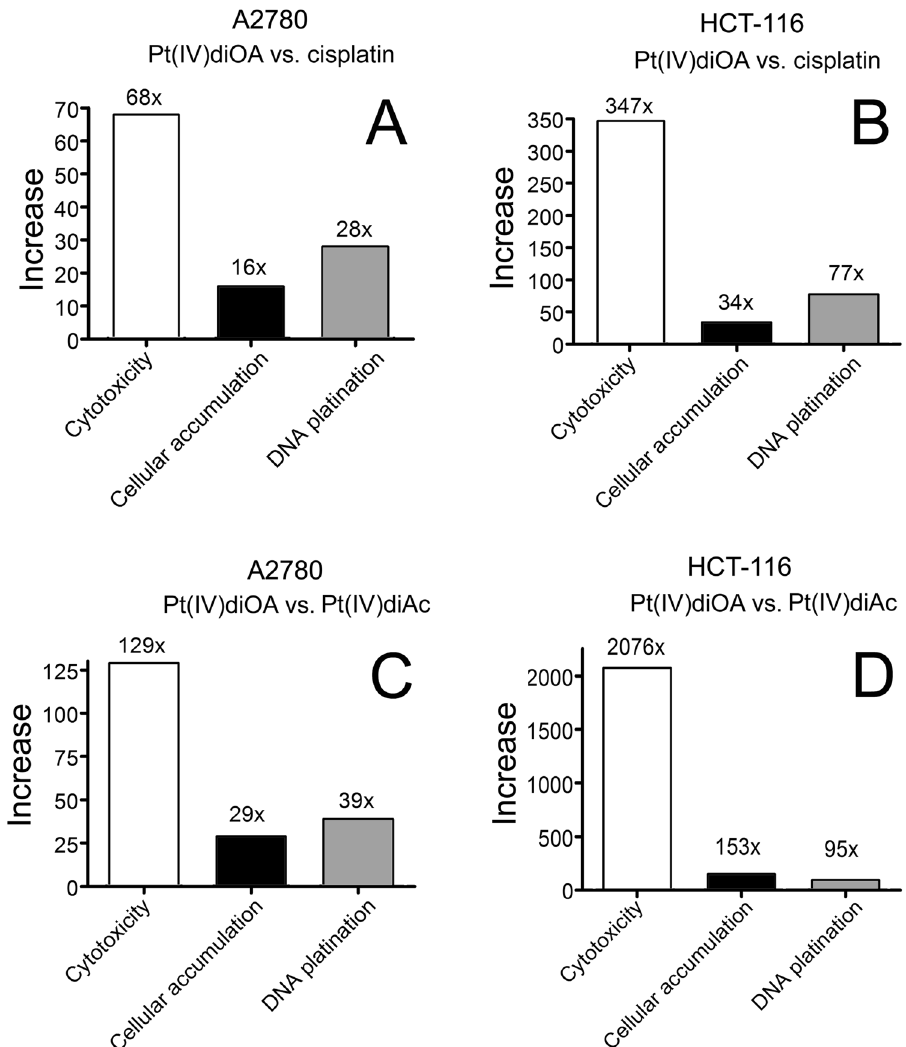
Figure 2. Increase of cytotoxicity, intracellular accumulation and DNA platination in A2780 ( A , C ) and HCT- 116 ( B , D ) cells treated with Pt(IV)diOA in comparison with the treatment with cisplatin ( A , B ) or Pt(IV)diAc ( C , D